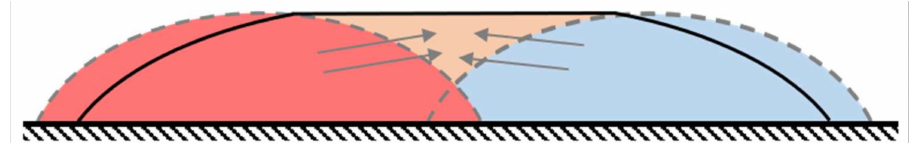
Figure 21. Cross-section of two coalescing drop lines and the resulting